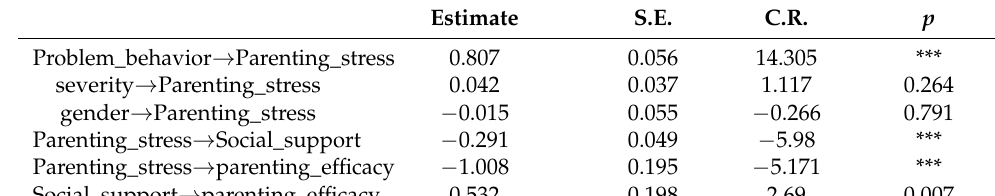
Table 3. The outcome of model fitting.